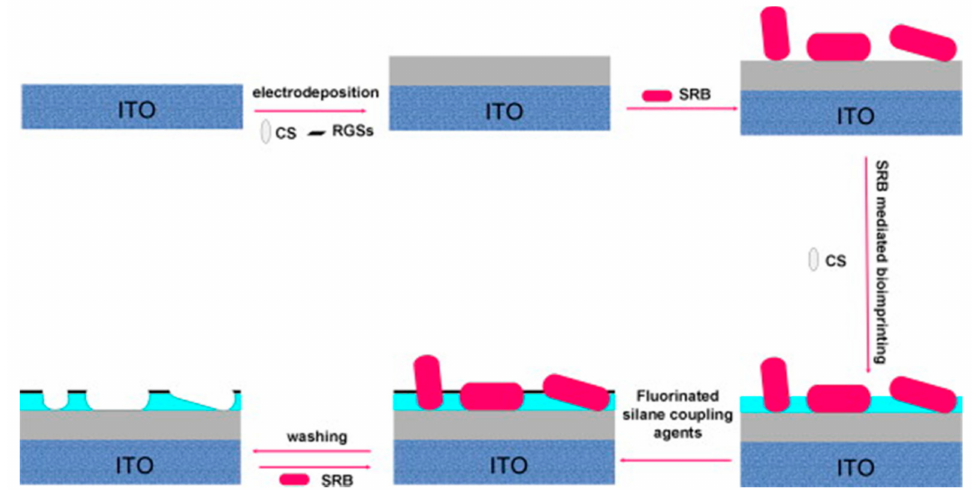
Figure 7. Methods of bacteria imprinting: surface imprinting of bacteria. Reproduced with permis- sion of Elsevier from